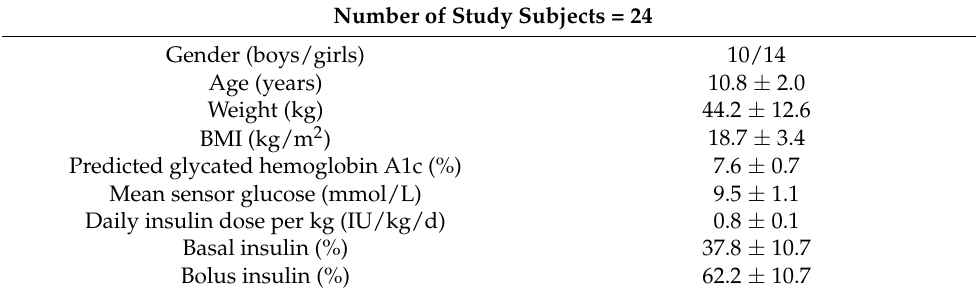
Table 1. Clinical characteristics of study subjects 1 .